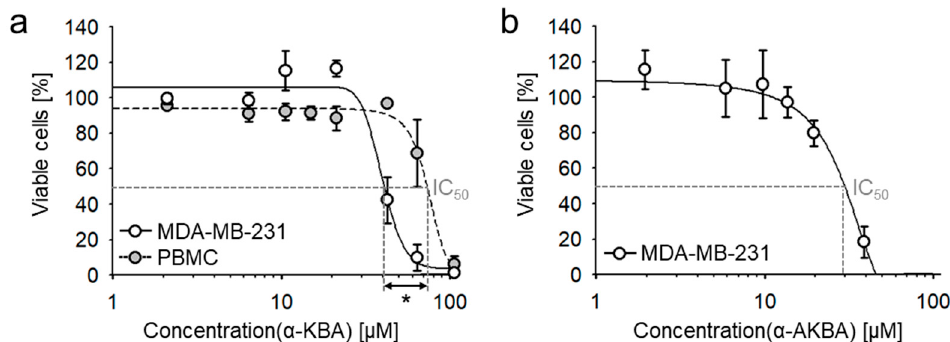
Figure 7. Cytotoxicity of 11-keto- α -boswellic acid ( α -KBA) and acetyl-11-keto- α -boswellic acid ( α -AKBA) against the human triple-negative breast cancer cell line MDA-MB-231 in vitro. ( a ) Comparison of the cytotoxic efficacies of α -KBA against MDA-MB-231 cells and human peripheral blood mononuclear cells (PBMC). Cancer cells were more sensitive to α -KBA than non-cancerogenic PBMC. ( b ) The acetylated form, α -AKBA, exhibits higher cytotoxicity compared to α -KBA. XTT (2,3-bis-(2-methoxy-4-nitro-5-sulfophenyl)-2H-tetrazolium-5-carboxanilide salt) assay, 72 h incubation, n = 3 (all biological replicates were performed in triplicates). Student´s t -test, * p < 0.05.